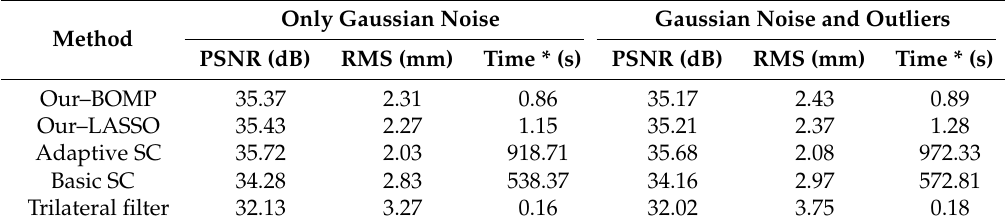
Table 4. Denoising results on real